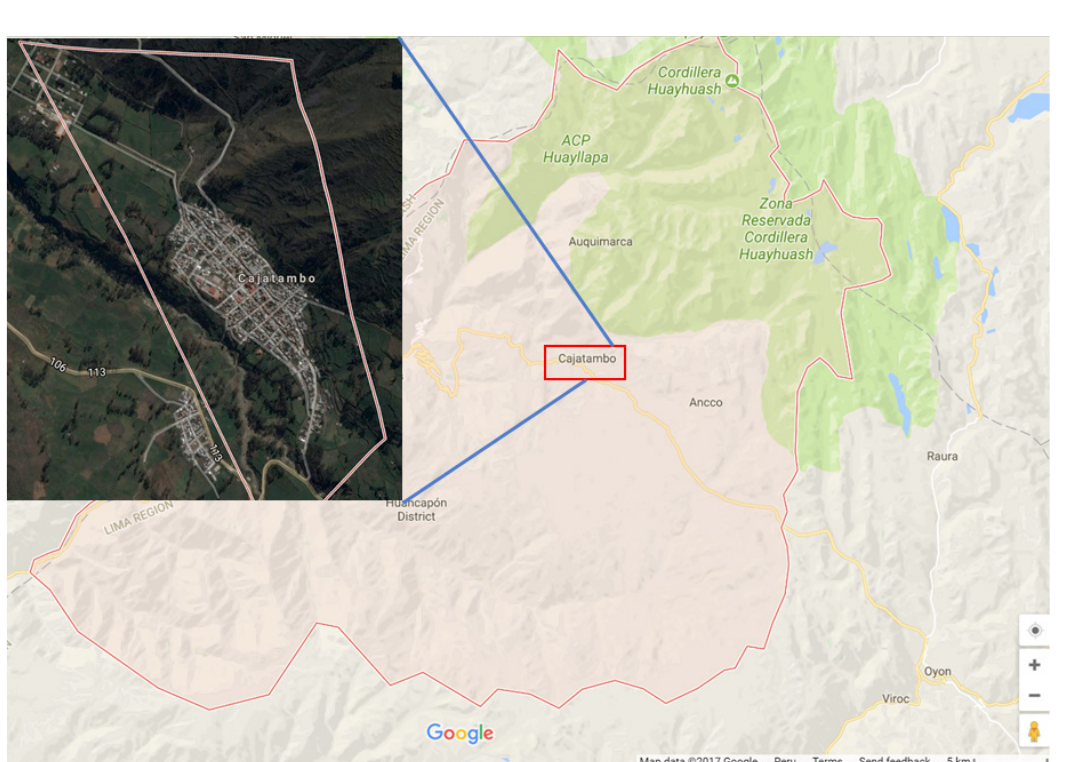
Figure 1: Province and District of Cajatambo. Source: Google Map Data (2017).